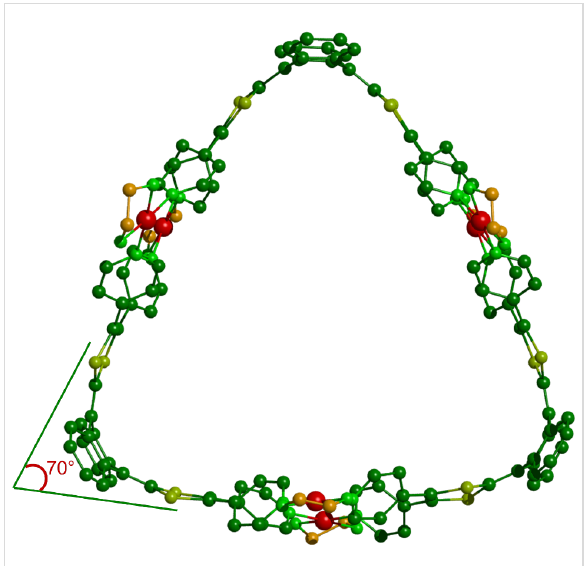
Figure 3: X-ray crystal structure of self-assembly M 6 L 3 . For clarity, H atoms and TfO − counteranions have been omitted.